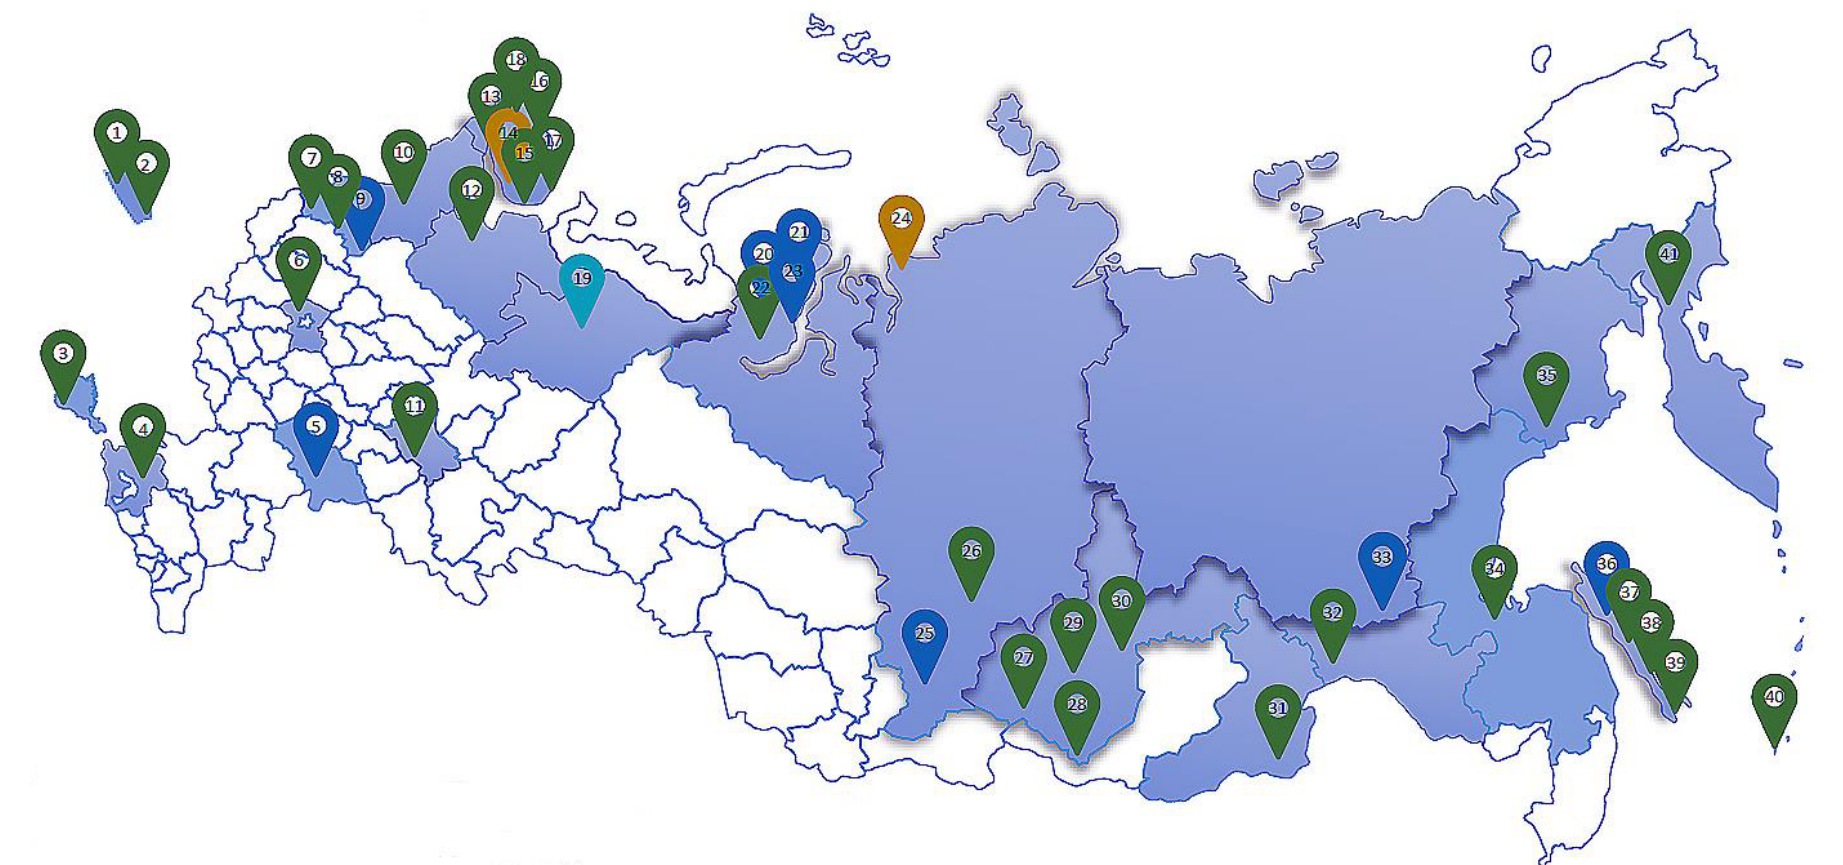
Figure 5. Hydrogen projects in Russia [51]. Note: the map of Russia shows the location and numbers of projects. The project profile is presented in Appendix A.